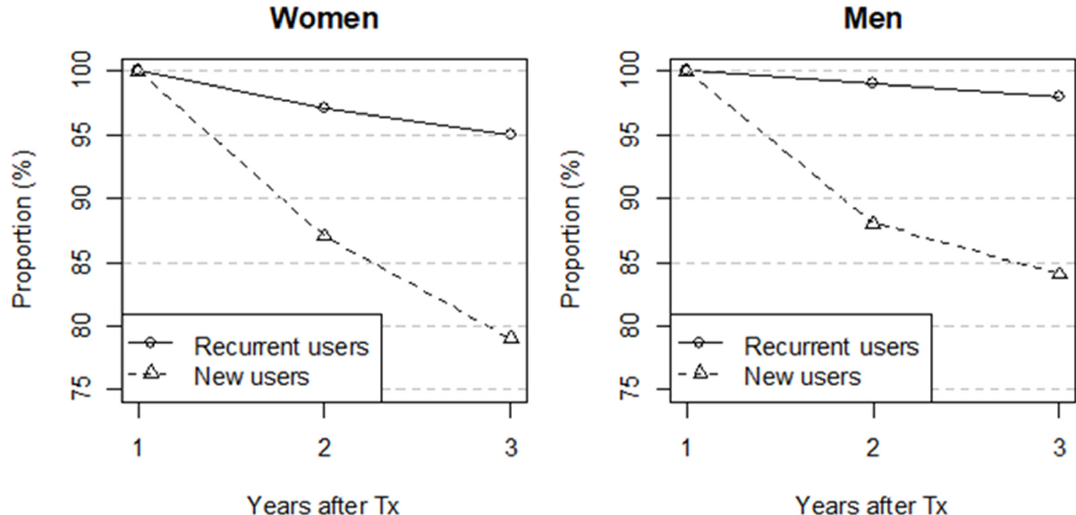
Figure 3. Adherence to statin treatment measured as the proportion (%) of new and recurrent users who had at least one statin dispensed the first year (year 1) after transplantation, according to sex. Year 2 includes those using statins both the first and second year, and year 3 includes patients using statins all three years after transplantation. The denominator is those still alive 2 and 3 years after transplantation, respectively. Tx–transplantation.